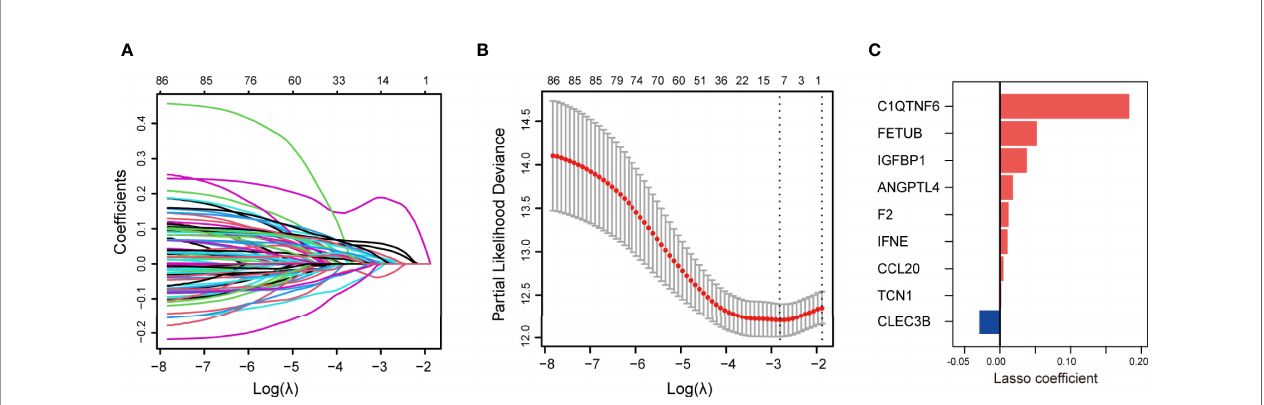
FIGURE 2 | Construction of secreted protein-related gene (SPRG)-related model for patients with lung adenocarcinoma (LUAD). (A) Least absolute shrinkage and selection operator method (LASSO) coef fi cient spectrum of differentially expressed secretory protein genes in The Cancer Genome Atlas LUAD cohort. (B) Cross- validation fi t curve calculated by LASSO regression method. (C) Distribution of LASSO coef fi cients of the